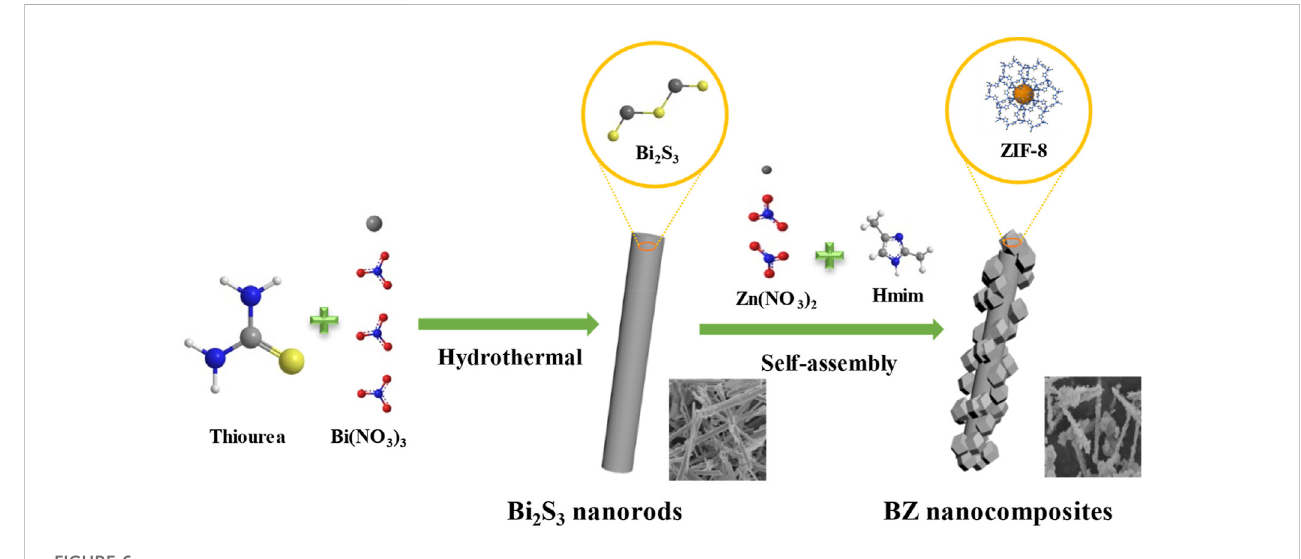
FIGURE 6 Fabrication of BZ core-shell nanocomposites (Chen et al., 2022).